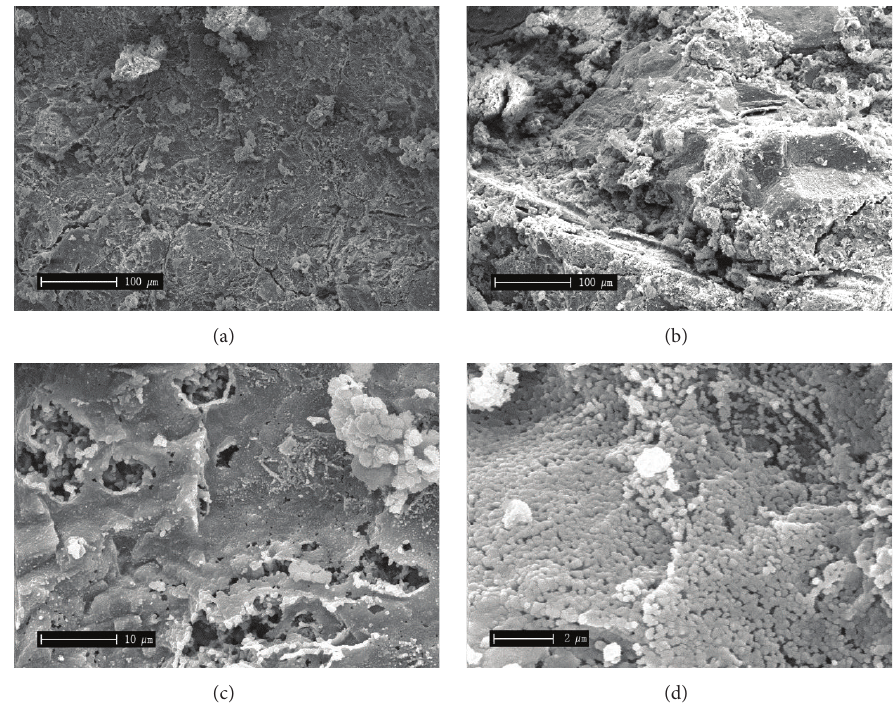
Figure 13: SEM images of microstructure of CFRC exposed at 1050 ∘ C for 4h at (a) 500x, (b) 500x, (c) 5000x, and (d) 20000x